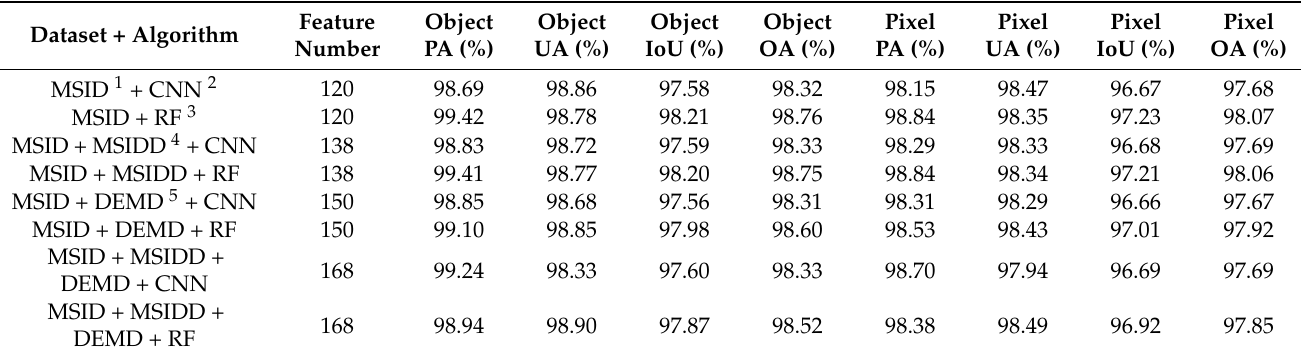
Table 4. Performance evaluation of snow mapping with different datasets and machine learning algorithms over the study area (excluding the training zone). Dataset + Algorithm